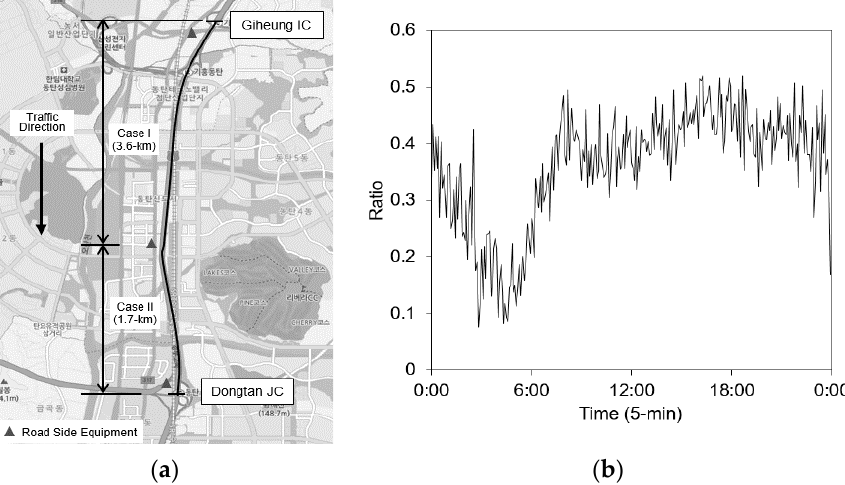
Figure 1. Study site and assumption of ground truth: ( a ) Gyeongbu Expressway, Giheung IC-Dongtan JC, ( b ) Ratio of traffic volume between loop detectors and ETC.